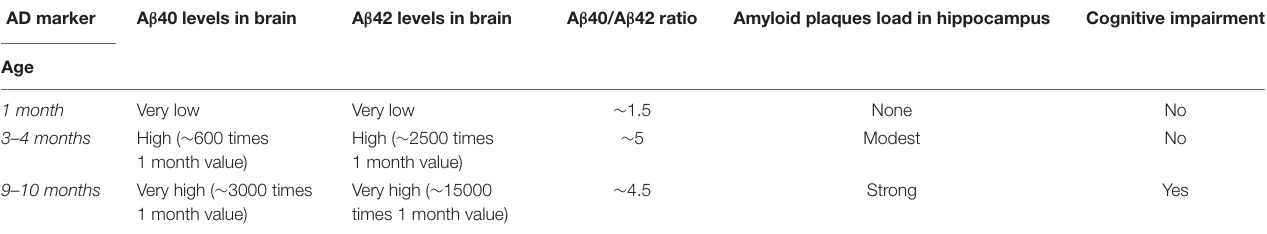
TABLE 1 | Stages of amyloidopathy in APPPS1 mice.